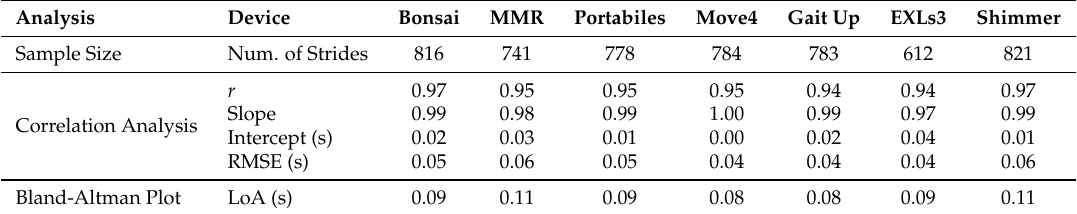
Table 9. Evaluation of stride times derived from IMU data with correlation analysis and Bland-Altman Plot. Analysis